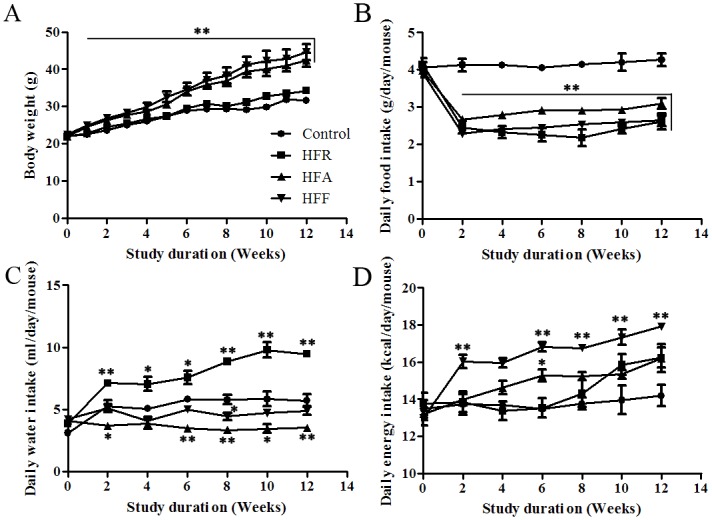
Effect of diet on body weight and energy intake.The C57BL/6 mice were fed with 20% fructose water (HFR), 60% fat diet (HFA), and 20% fructose water + 60% high fat diet (HFF) for 3 months. Body weights (A) were measured every week; food intake (B), water intake (C), and energy intake (D) were measured every other week. Data are presented as means ± SD (n ≥ 6 in each group). The following abbreviations are used throughout the figures: control, mice fed with normal water and diet; HFR, mice fed with 20% fructose water; HFA, mice fed with 60% fat diet; HFF, mice fed with 20% fructose water and 60% fat diet. *P<0.05 versus control at the same time point, **P<0.01 versus control at the same time point.